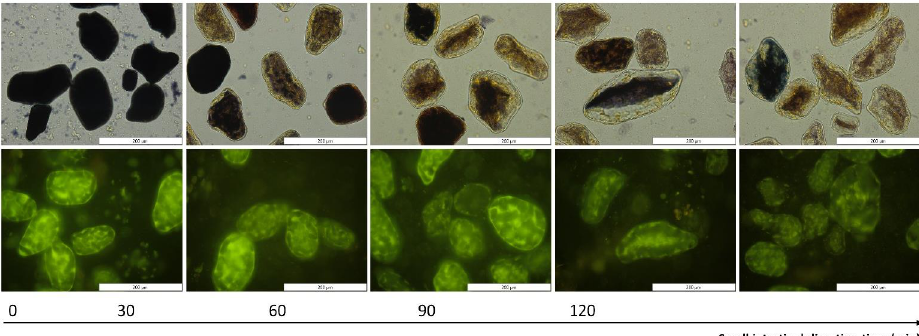
Figure 6. Representative micrographs of digested pellets of isolated cotyledon cells (with a cooking time of 30 min) as a function of small intestinal digestion time. First row: gradual amylolysis was visualized by staining with Lugol (dark blue). Second row: proteolysis was visualized using (green) fluorescence microscopy (exposure time 500 ms). A magnification of 40× was utilized and the scale bars represent a length of 200 µm.